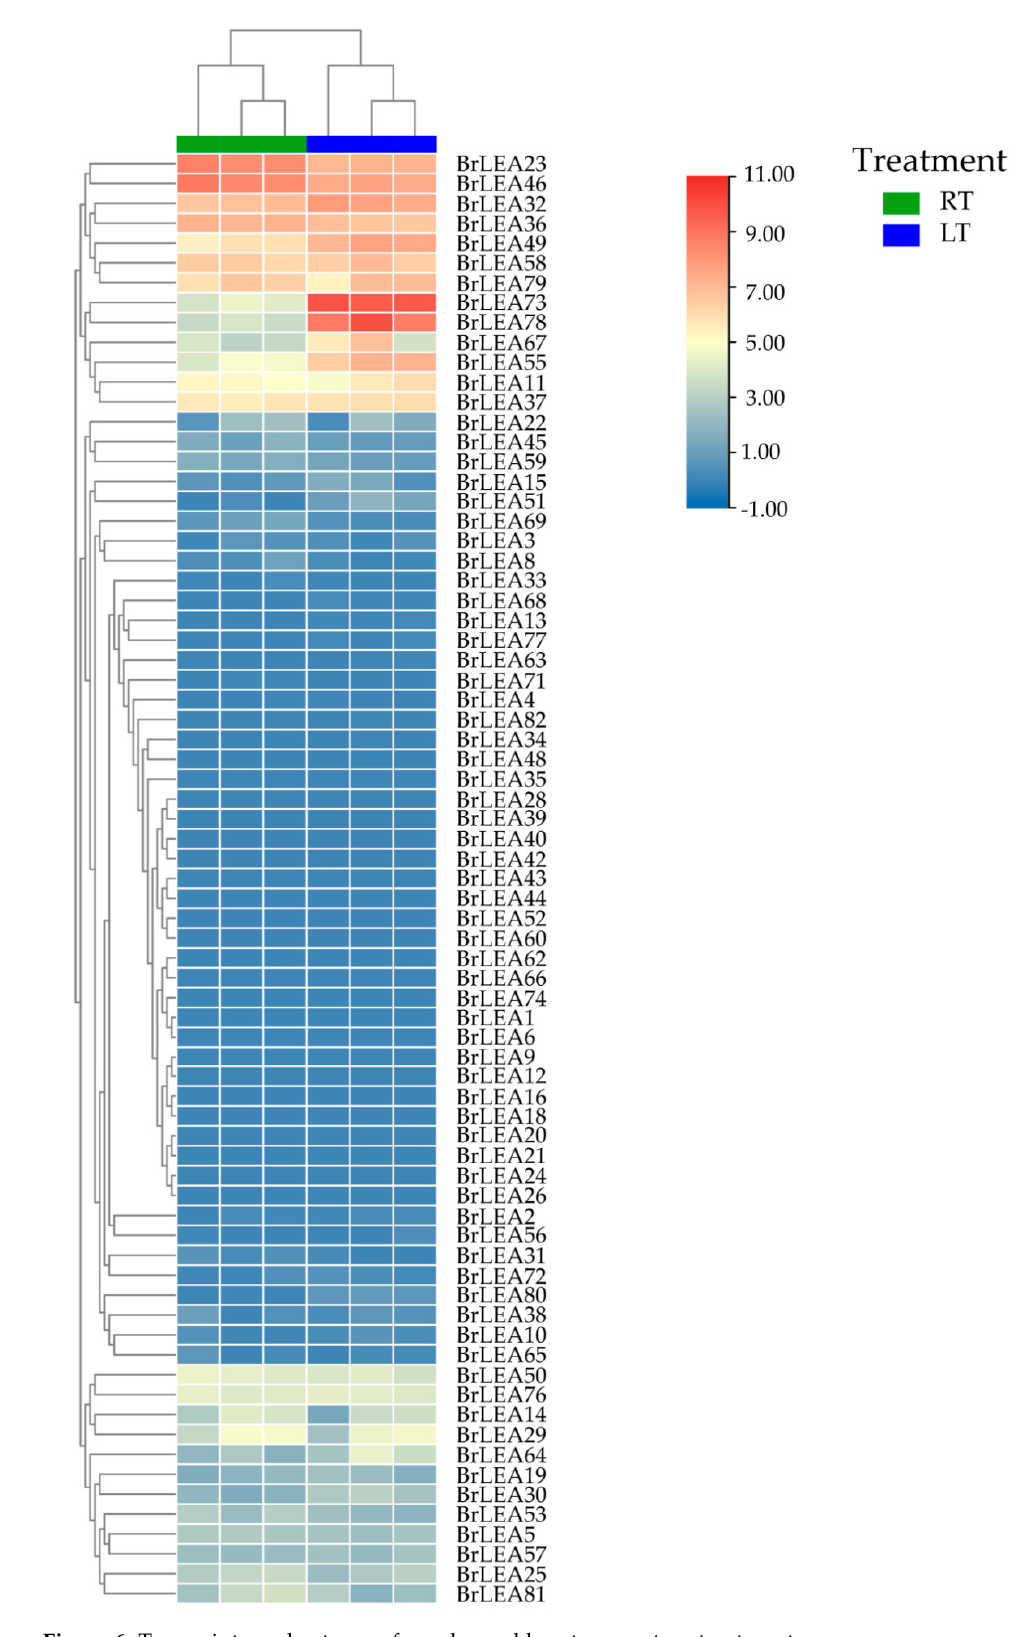
Figure 6. Transcriptome heatmap of regular and low ‐ temperature treatments.